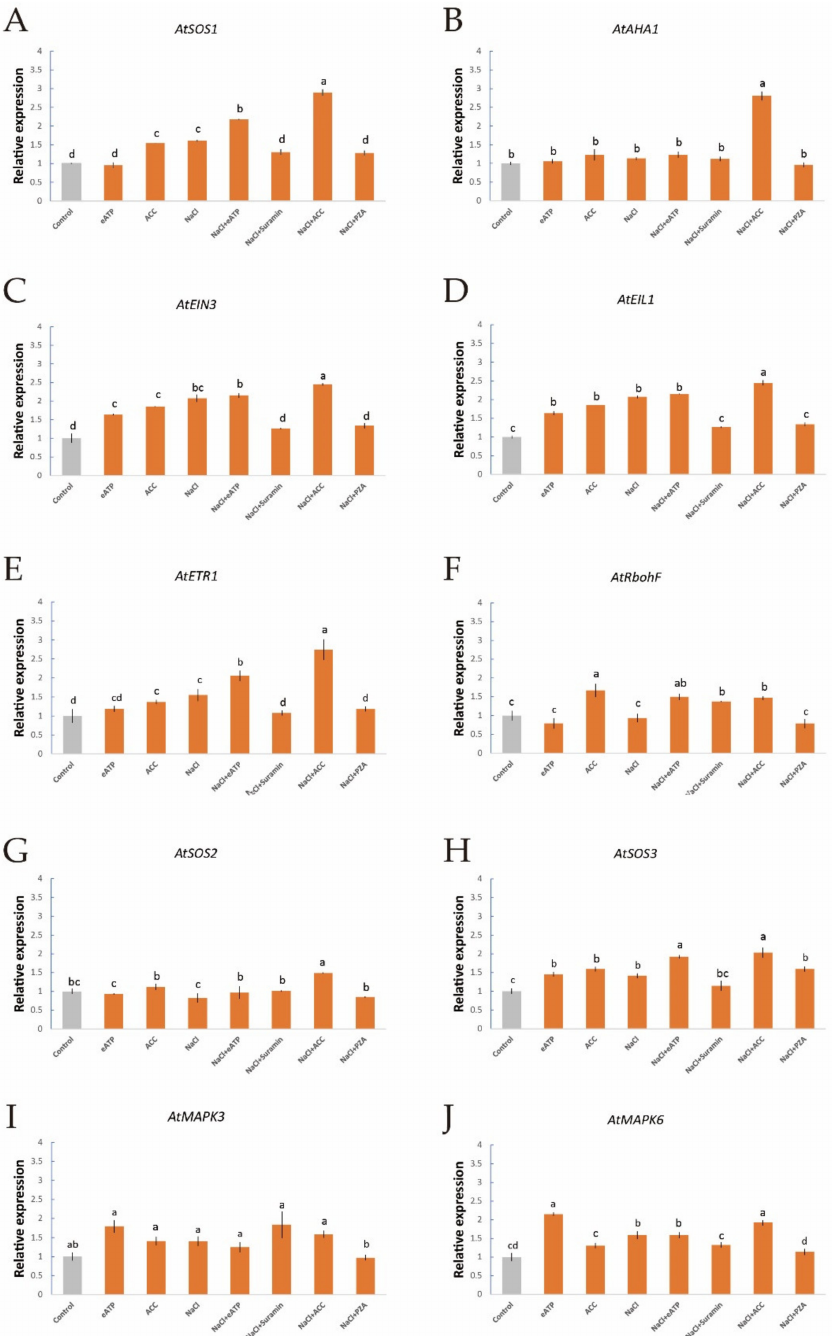
Figure 7. E ff ects of ACC and eATP on salt-responsive gene transcription of Col-0 roots under salt stress. Roots were exposed to 0 or 100 mM NaCl for 12 h, supplemented with or without ACC (10 µ M) or ATP-Na 2 (300 µ M). Quantitative RT-PCR results show the relative transcript abundance of homolog genes in Col-0, such as ( A ) AtSOS1 (the PM salt overly sensitive 1 / (Na + / H + ) antiporter), ( B ) AtAHA1 (the PM H + -ATPase), ( C ) AtEIN3 (the ethylene insensitive 3 gene), ( D ) AtEIL1 (the EIN3-like 1 gene), ( E ) AtETR1 (the ethylene response 1 gene), ( F ) AtRbohF (the respiratory burst oxidase homolog protein F gene), ( G ) AtSOS2 (the salt overly sensitive 2 gene), ( H ) AtSOS3 (the salt overly sensitive 3 gene) and ( I , J ) AtMAPK3 / 6 (the mitogen-activated protein kinase 3 / 6 genes). AtActin2 served as an internal control for expression normalization. Forward and reverse primers for all tested genes are listed in Table S1. Bars ( ± SD) represent the means of three to five individual plants; a-f indicate significant di ff erences between treatments ( p <